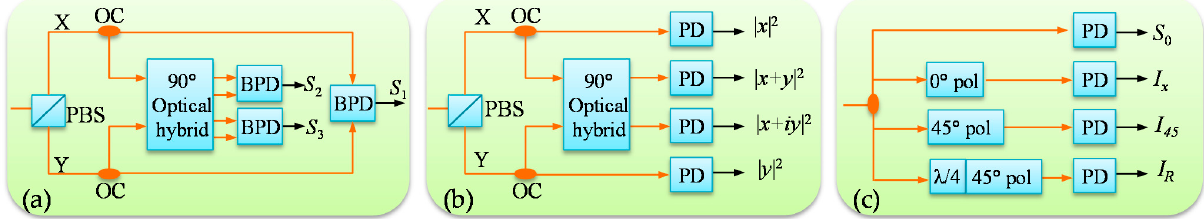
Figure 6. Different structures of Stokes vector direct detection: ( a ) structure I [19]; ( b ) structure II; ( c ) structure III [21]; PBS: polarization beam splitter; OC: optical coupler; BPD: balanced photodetector; pol: polarizer.